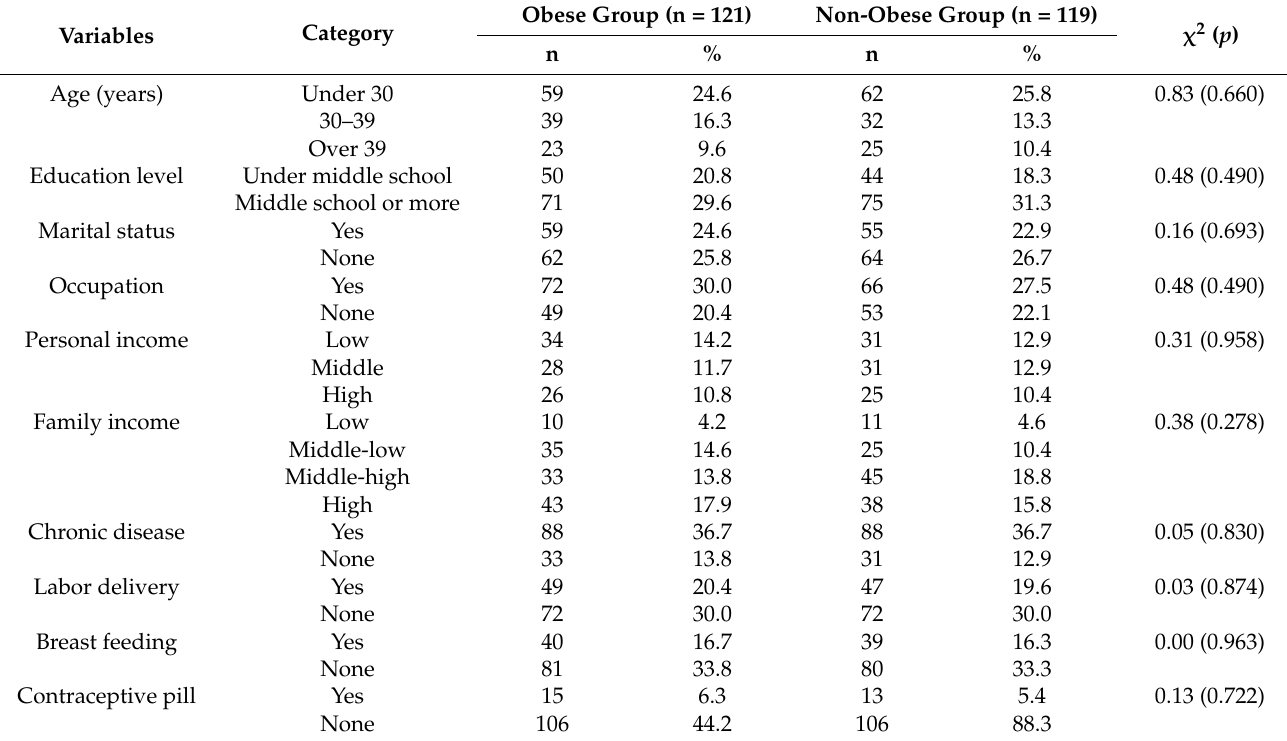
Table 2. Homogeneity of subjects’ characteristics after